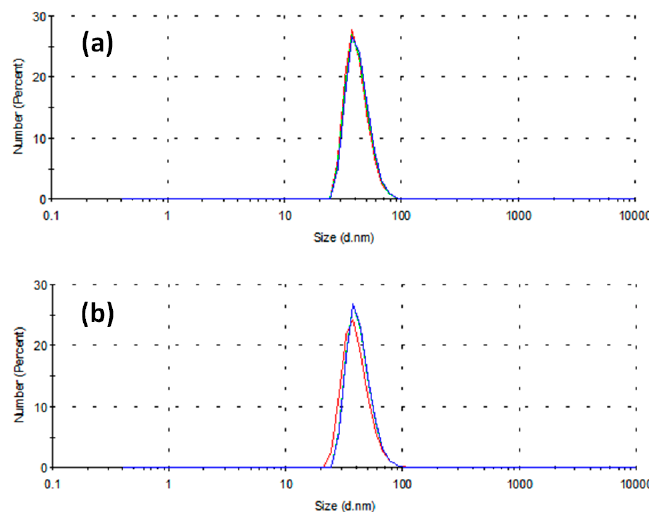
Figure 1. Distribution of particle diameters populations by number versus diameters obtained by DLS. ( a ) Specimen obtained using PVP 40 k as stabilizing agent; average diameter = 41.8 nm; and ( b ) specimen obtained using SDS as stabilizing agent; average diameter = 40.5 nm. In each plot, the curves refer to three different sampling times differing by 5 min from one another.